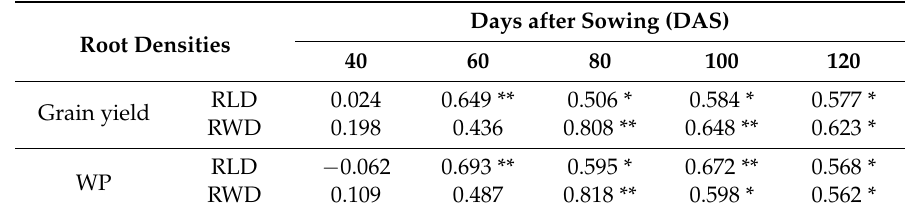
Table 5. Correlations between both grain yield and WP and root densities measured at different days after sowing of summer maize in various organic amendment management systems.